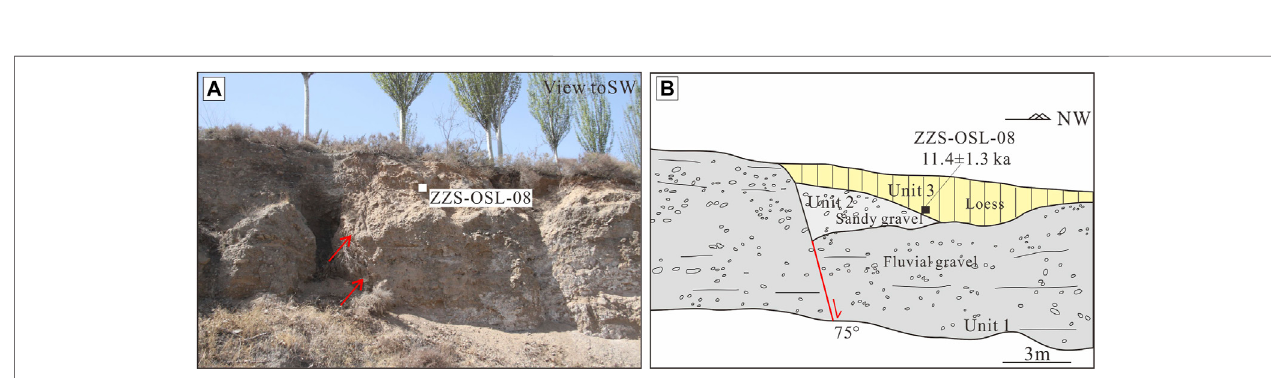
FIGURE 7 | Fault outcrop (A) and corresponding sketch (B) at the Dongshanbei site. Red arrows indicate the location of fault plane. One major normal fault is prominent, displacing sedimentary Unit 1. One OSL sample (ZZS-OSL-08) collected above the inferred colluvial wedge was dated, yielding an age of 11.4 ± 1.3 ka (Table 1)